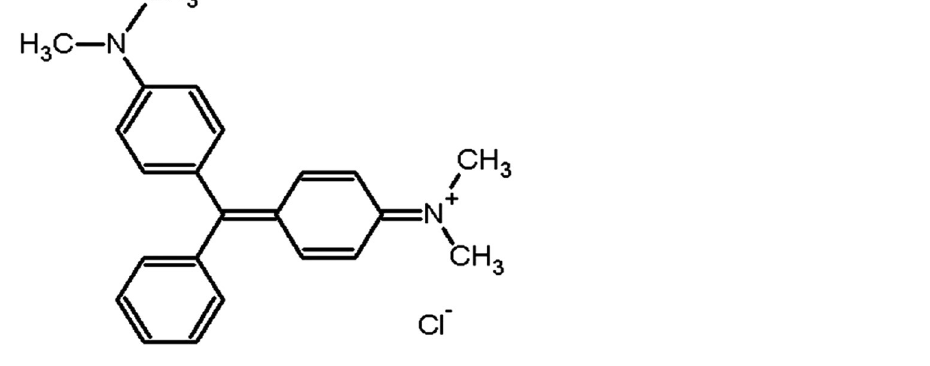
Figure 1. Molecular structure of Malachite